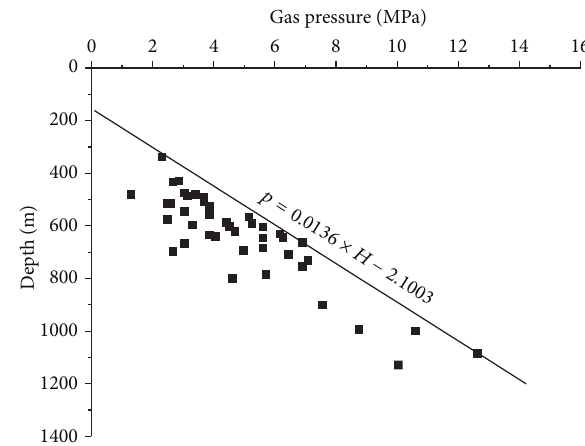
Figure 5: The relationship between gas pressure and depth of No. 3 coal seam in the